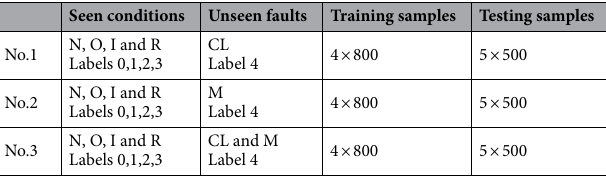
Table 10. Descriptions of industrial experiments.